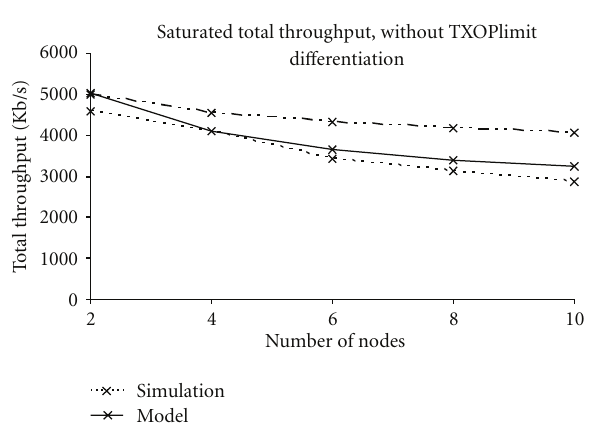
Figure 15: Total throughput, without TXOP.